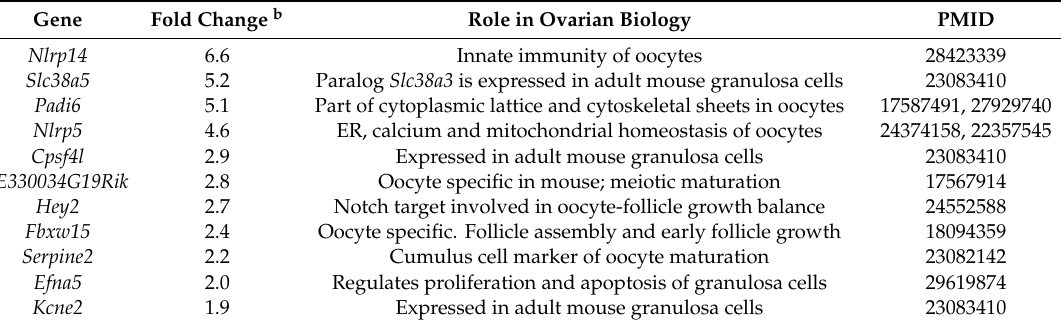
Table 3. Follicle and oocyte-related genes not annotated in GO a